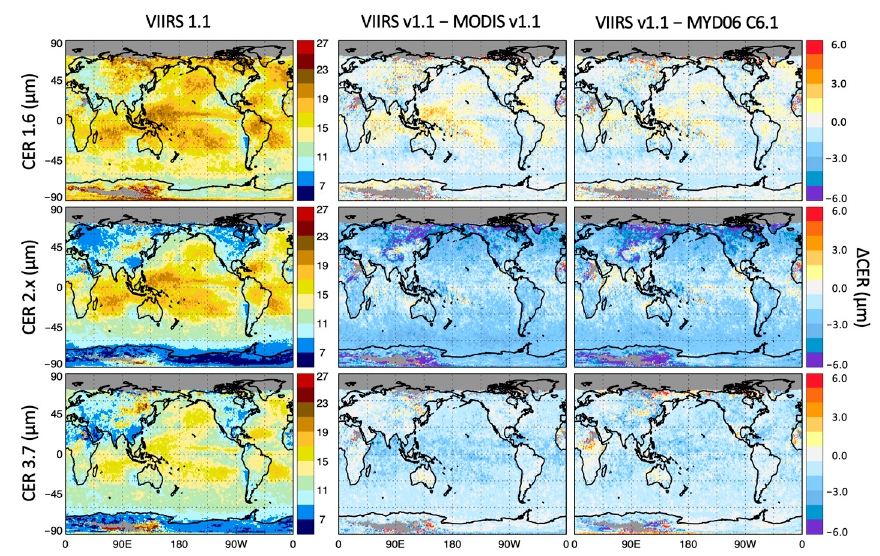
Figure 7. Comparison of February 2014 gridded (1 ◦ ) mean spectral CER retrievals from Aqua MODIS and Suomi National Polar-orbiting Partnership (SNPP) VIIRS using the same SWIR and MWIR index of refractions datasets as in the MODIS standard cloud optical property algorithm for all images (i.e., 300 K LUTs, see text for details). Mean CER for the VIIRS continuity algorithm (equivalent to version 1.1 other than index of refraction dataset choices) are shown in the left column. CER di ff erences are shown between VIIRS and the corresponding MODIS continuity means ( middle ), and between VIIRS and the standard MODIS C6.1 Level-3 product MYD08 ( right